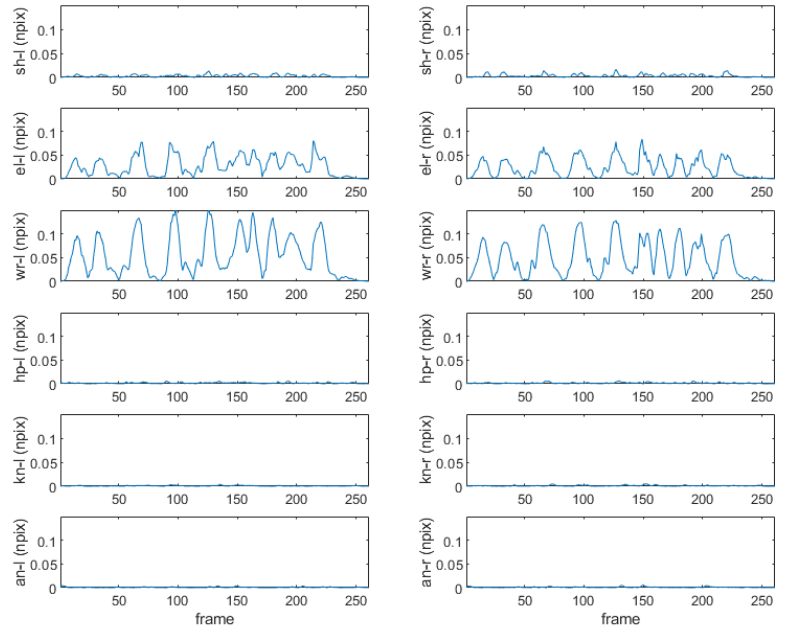
Figure 5. Change distance profiles of left (l)/right (r) shoulder (sh), elbow (el), wrist (wr), hip (hp), knee (kn), and ankle (an) joint landmark positions in normalized pixels (npix) for the motion in Figure 4.